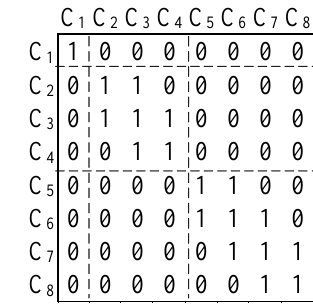
Figure 8. Cluster spanning tree.